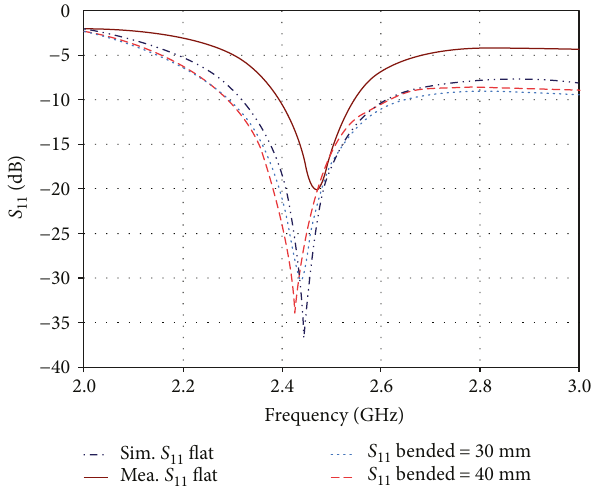
Figure 7: The re fl ection coe ffi cient S antenna with and without bending conditions.